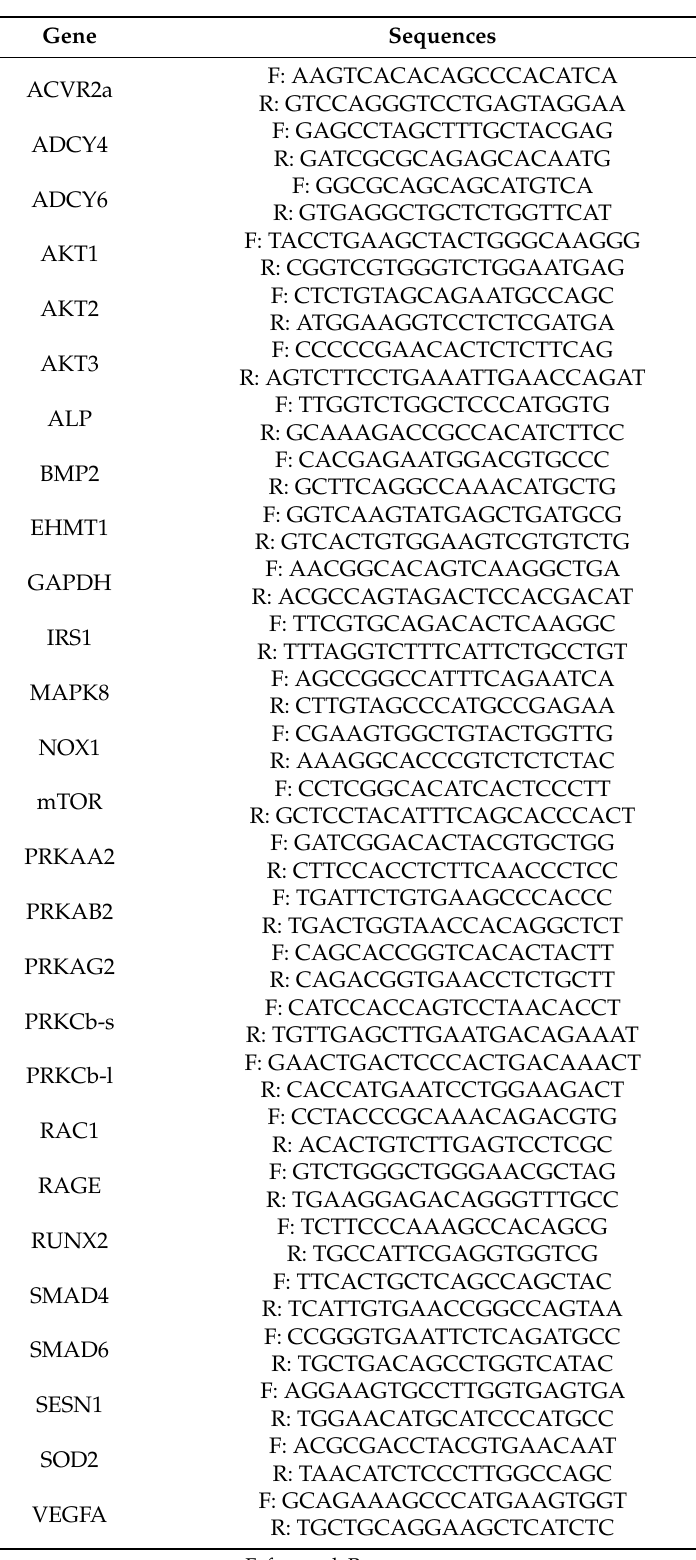
Table 1. Primer sequences used in this